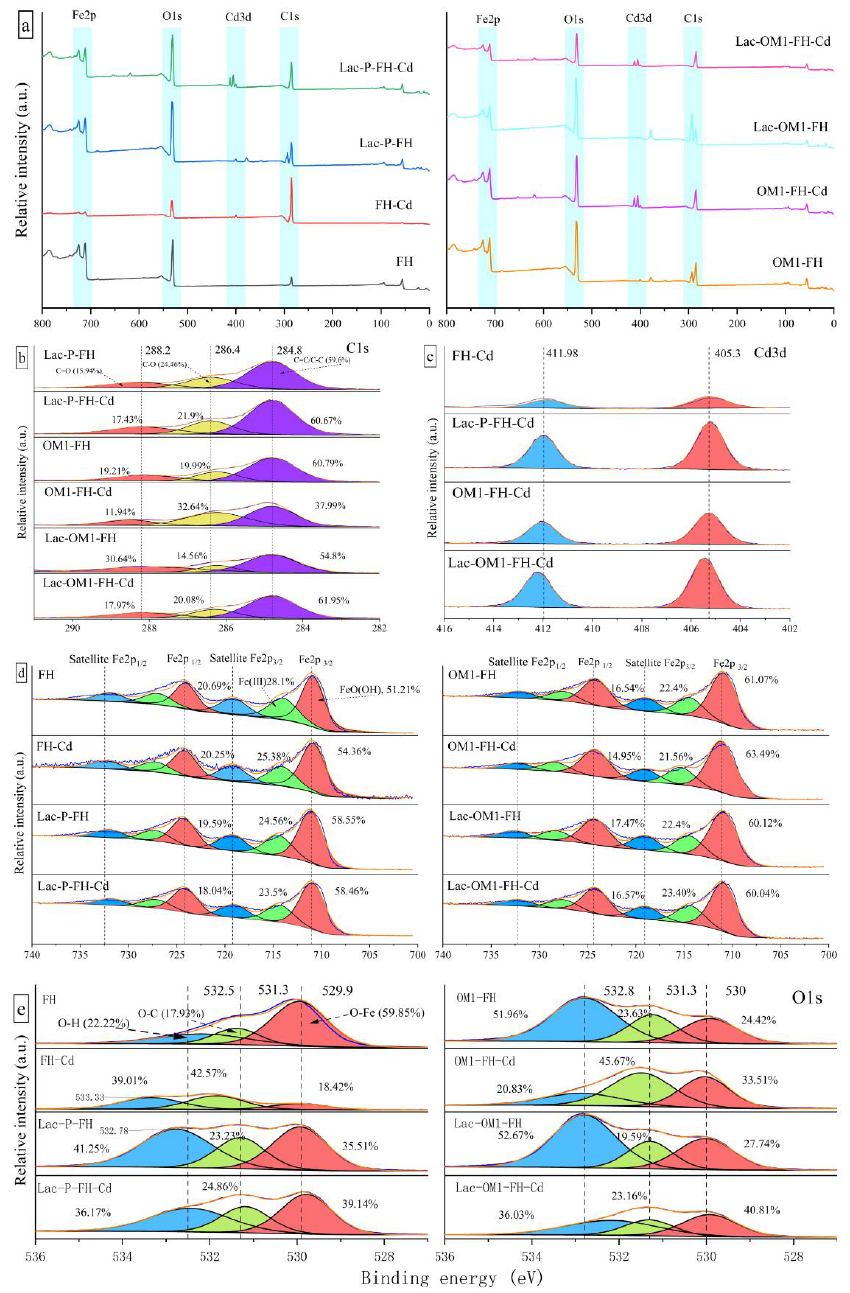
Figure 9. XPS spectrum of FH and Fe-OM before and after adsorption: ( a ) full XPS spectrum; ( b ) C1s spectrum of Lac-P-FH, OM1-FH and Lac-OM1-FH before and after adsorption; ( c ) Cd3d spectrum of FH, Lac-P-FH, OM1-FH and Lac-OM1-FH; ( d , e ) Fe2p and O1s spectrum of FH and Fe-OM before and after adsorption.